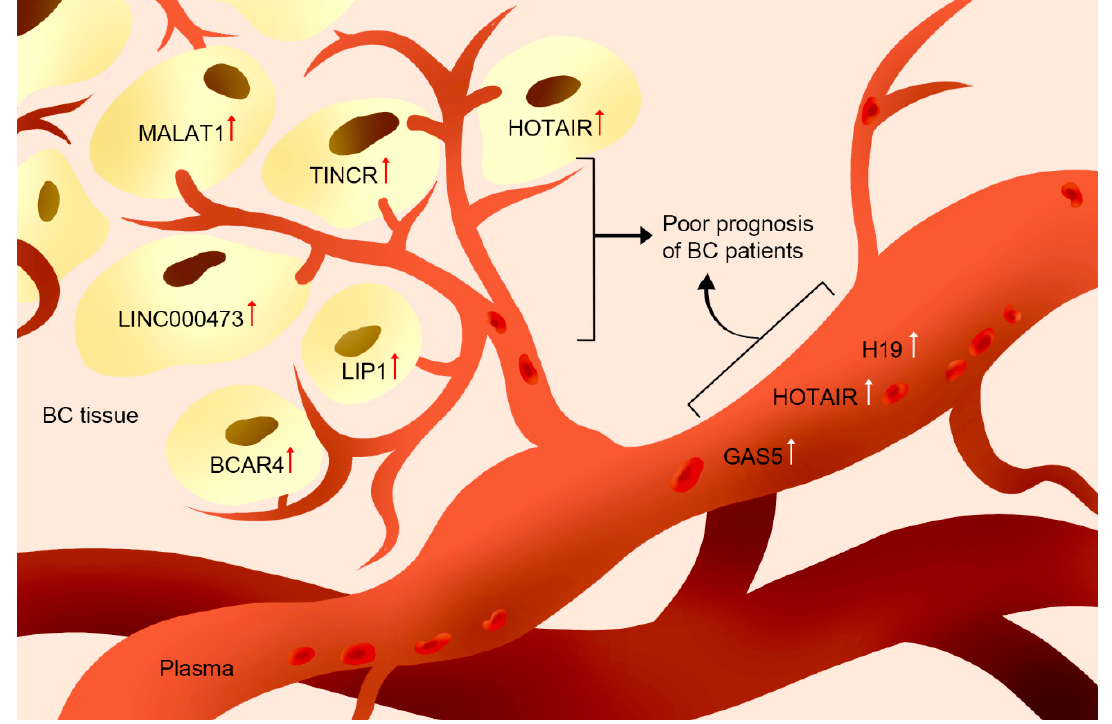
Figure 1. LncRNAs and prognosis of BC patients. Here both up-regulated lncRNA in BC tissue (HOTAIR, TINCR, LIP1, MALAT1, and LINC000473) and circulating lncRNA in plasma (HOTAIR, H19, and GAS5) predict poor prognosis of BC patients. The red or white up arrows respectively refer to up-regulation of the relevant lncRNA in BC patients’ tissue or plasma.